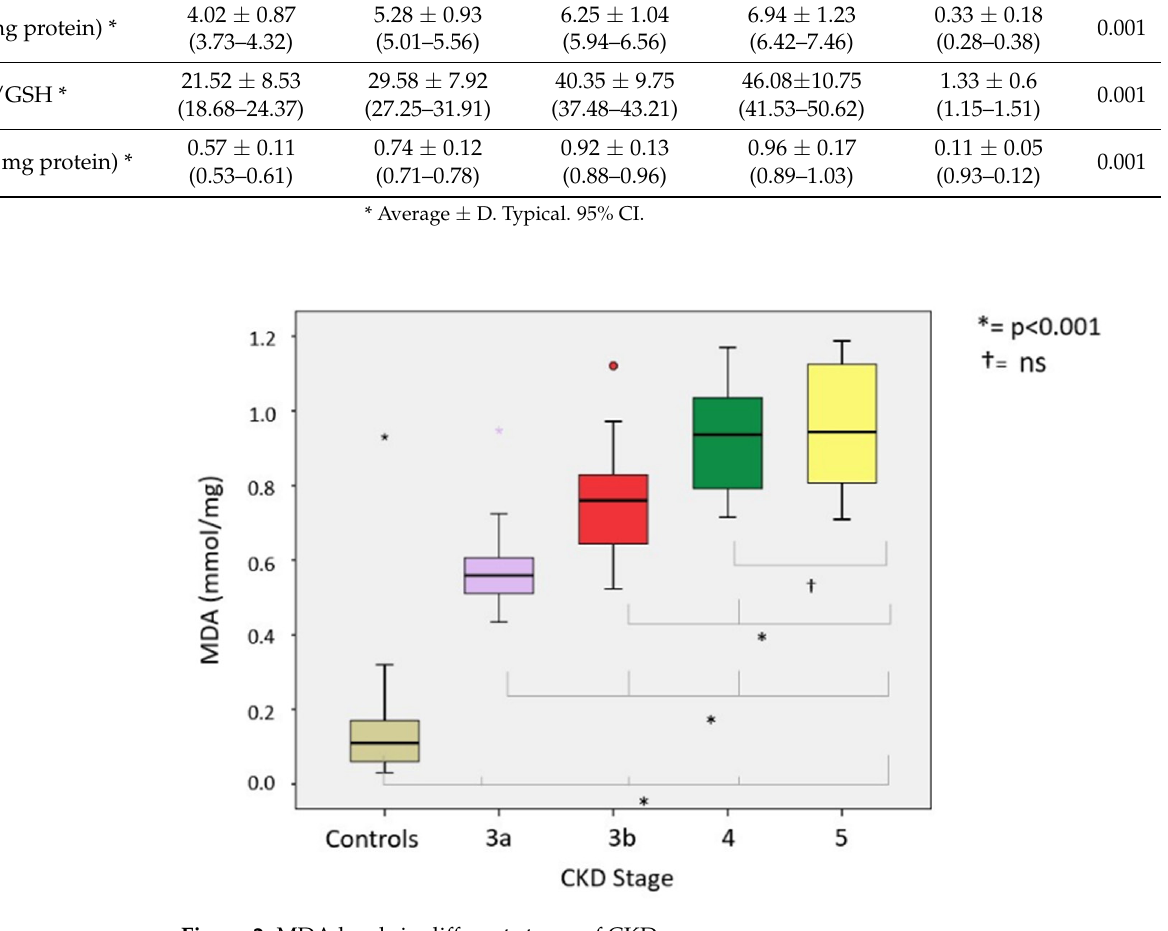
Figure 3. GSSG levels in different stages of CKD.